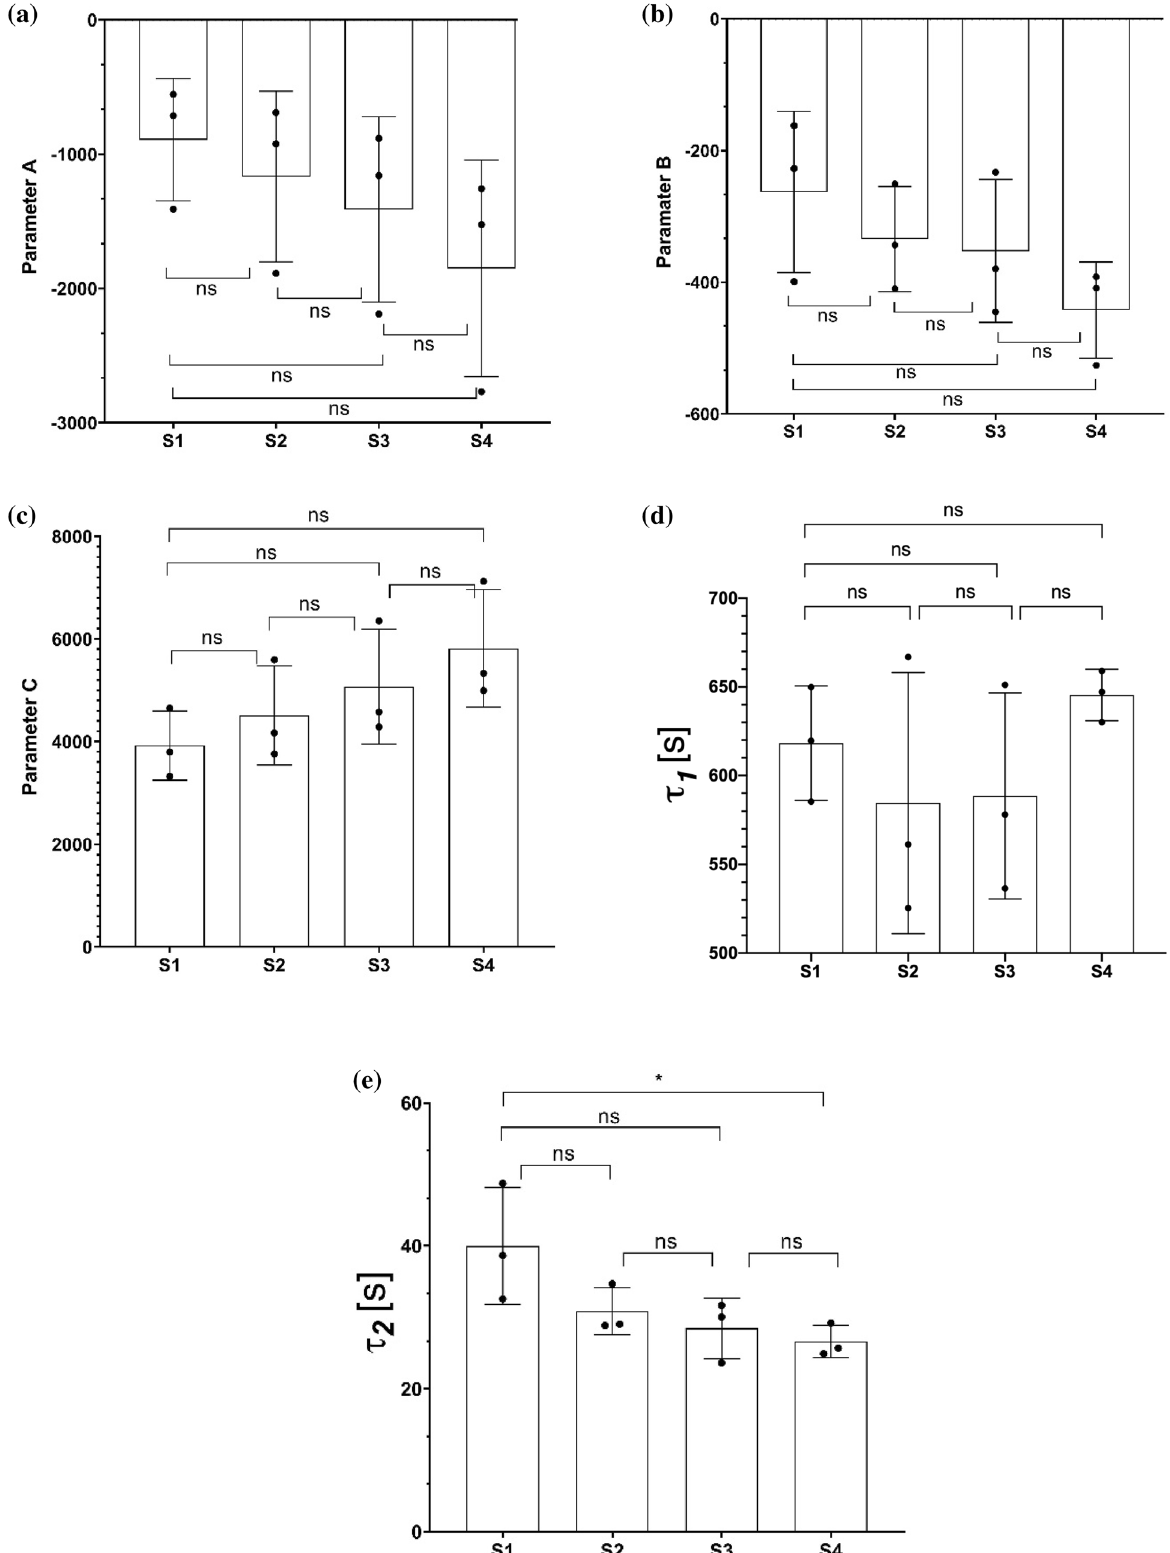
Figure 3. Emprical model parameters ( A ( a ), B ( b ), C ( c ), , τ 1 ( d ), and τ 2 ( e ). The data is computed using the experimental data from measurements and Eq. (11). Results are shown using box plots. One-way ANOVA with Tukey’s post-hoc test is used for multiple comparison. Probability values are indicated on figures by asterisks, as follows: *p < 0.05; **p <